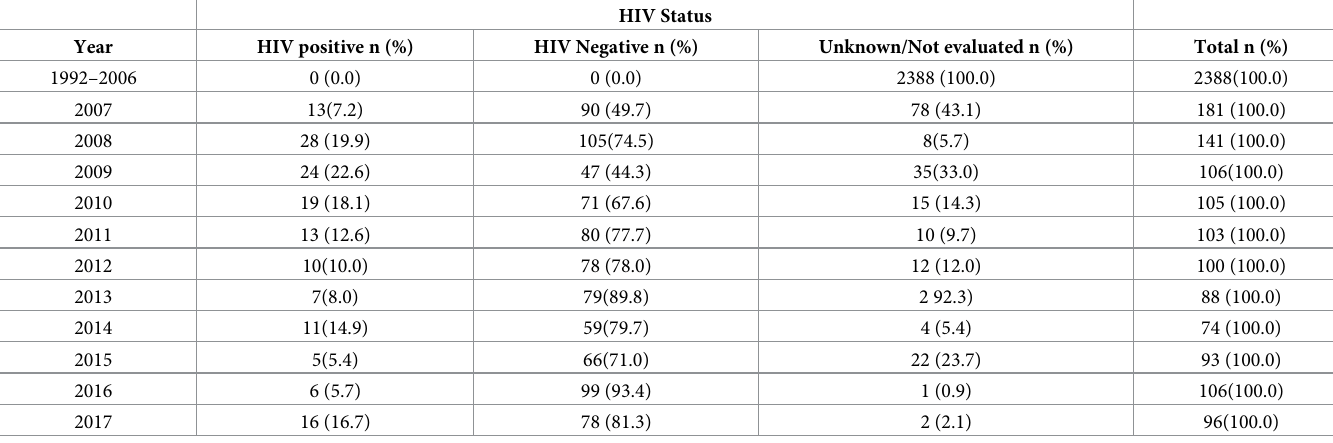
Table 2. Proportion of patients screened for HIV infections in the tuberculosis treatment